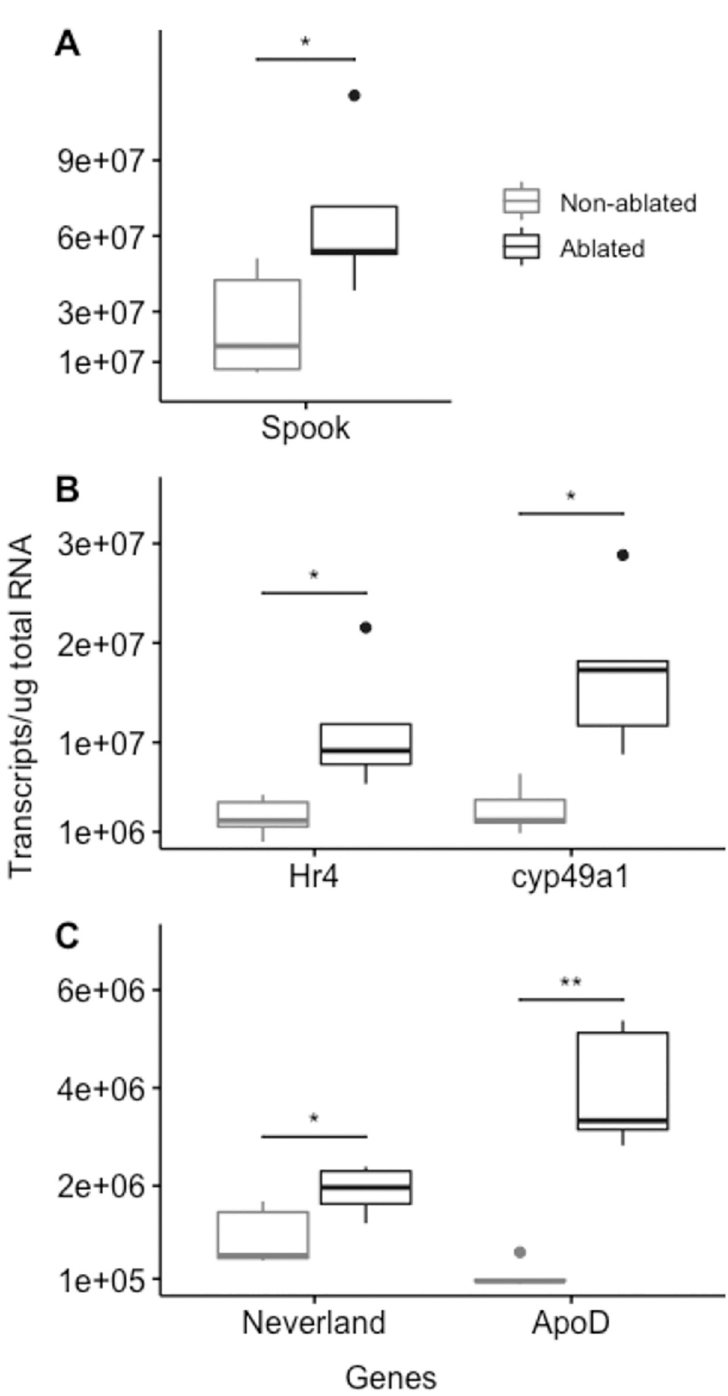
Fig 6. Boxplot representation of the candidate gene expressions in the YO of non-ablated animals (IM) and eyestalk ablated C . sapidus (iePM). Gene expression was measured by absolute qPCR assays and presented as the number of transcripts/ μ g total RNA. Non-ablated control animals are shown in light grey, eyestalk-ablated animals (ablated) in dark grey. (A) Expression of Spook . (B) Expression of Hormone receptor 4 (Hr4) and probable cytochrome p450 49a1 ( cyp49a1) . (C) Expression of Neverland and Apolipoprotein D-like (ApoD) . The expression levels of each gene measured in non-ablated and ablated samples were examined for statistical significance by Student’s t -test. Statistical differences were noted as” � ” P < 0.05, “ �� ” P < 0.01. The dots represented outliers in the